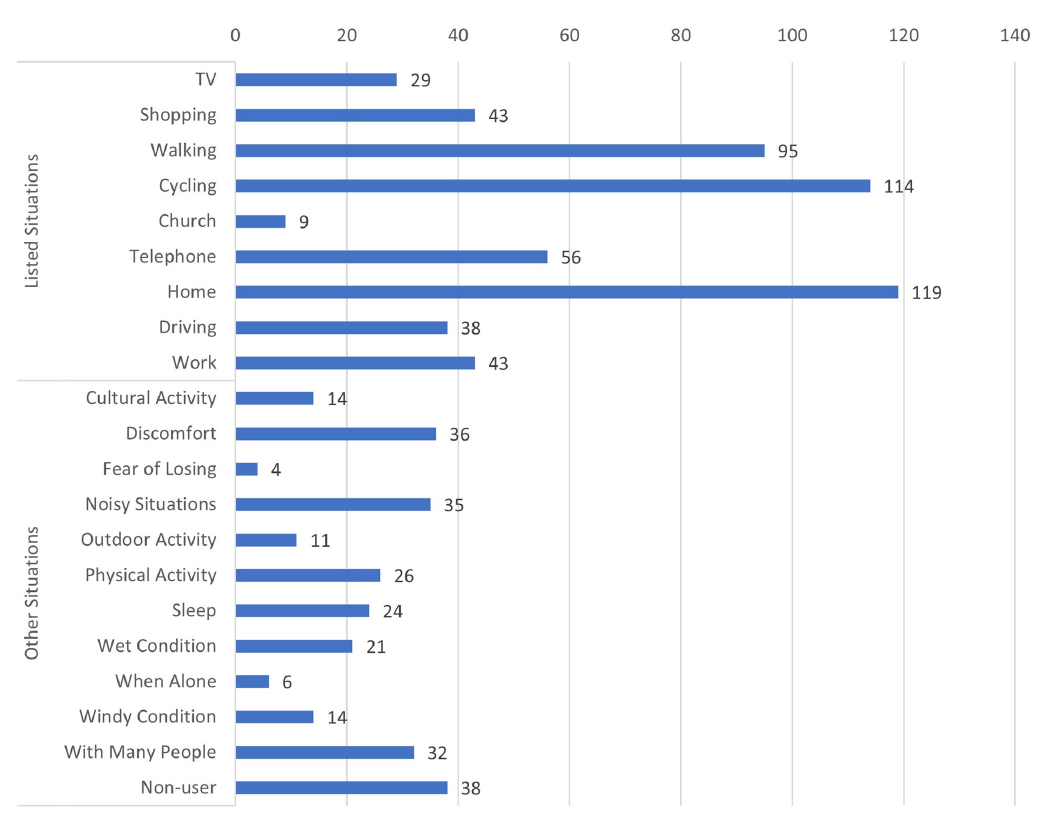
Figure 1. Situations where HA users always took off their HAs. The numbers beside the bar are the number of participants responding to the given specific situation where they always took off their HAs. The categories of situations listed from “TV” to “Work” were the listed situations, and the rest from “Cultural Activity” to “With Many People” are categories derived from the theme analysis of the free-text responses delivered by the HA users using the “other” option.